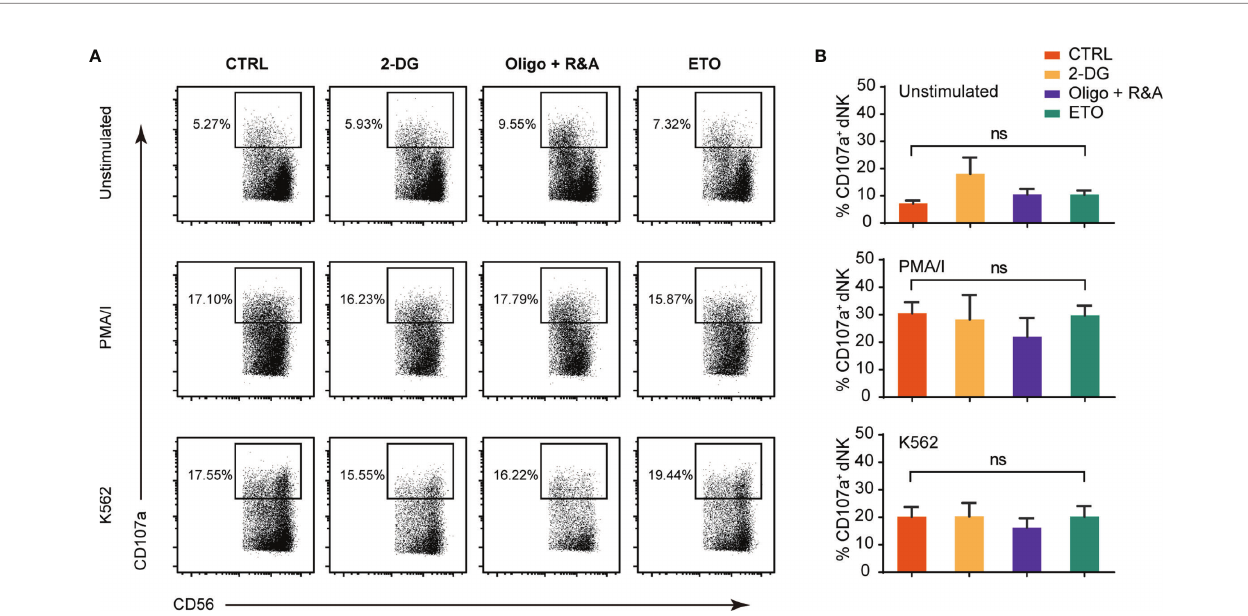
FIGURE 3 | Metabolism blockage has minimal effects on dNK cytotoxicity abilities. (A) Representative FCM plots of CD107a staining of gated CD3 - CD56 + NK cells in decidual immune cells (DICs) cultured alone (top panels), with PMA/I (middle panels, 2.5 ng/ml PMA in combination with 0.1 mg/ml ionomycin), and with K562 (bottom panels). (B) Percentage of CD107a+ NK cells upon being cultured alone (upper), with PMA/I (middle), and K562 (lower). All cells were cultured in the presence of 2.5 ng/ml IL-15 for 2 h added with CD107a antibody. (n = 4 – 5, nonparametric one-way ANOVA). ns, not signi fi